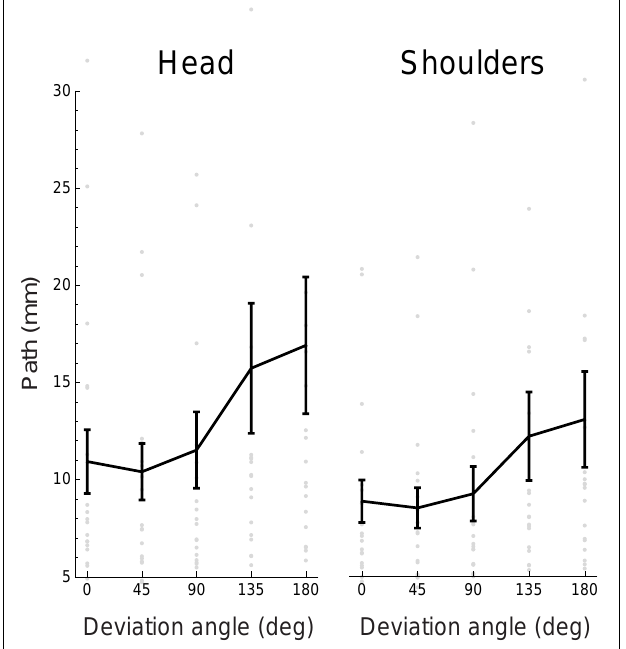
FIGURE 7 |Absolute rotation amplitude, for the head and shoulders, as a function of the absolute deviation angle. Gray dots represent individual participants’ data, the black curve the mean, and error bars between-subject SE. Several outlying datapoints are not